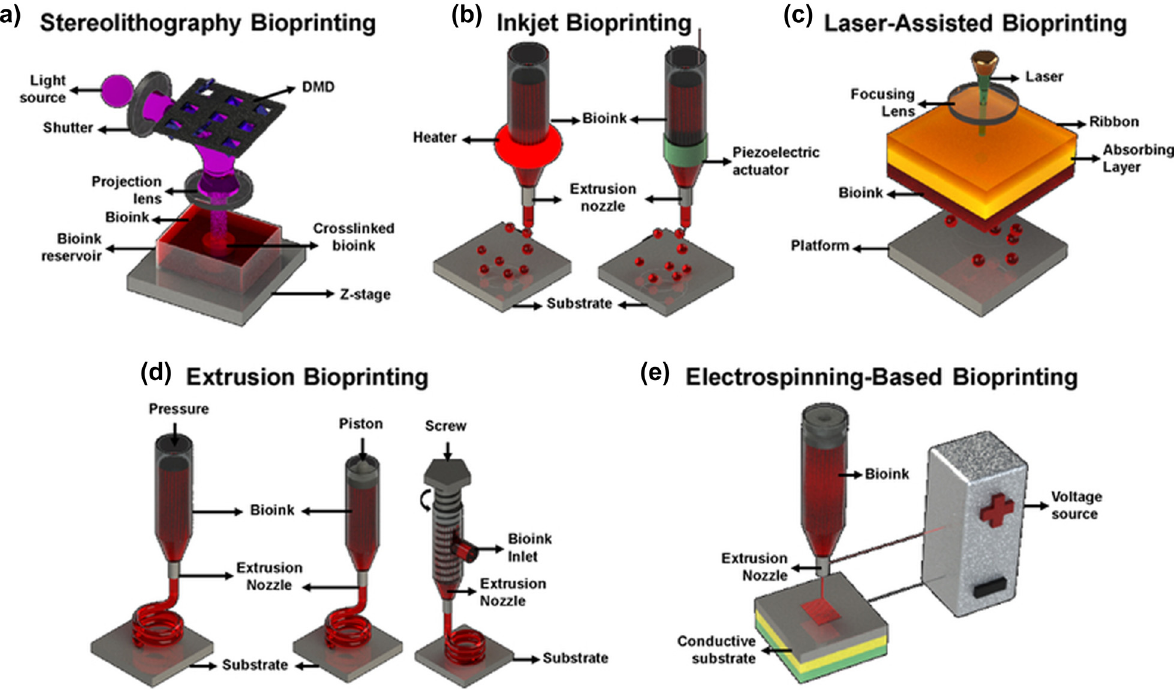
Figure 6: Schematic diagram of di ff erent 3D bioprinting technologies: ( a ) SLA - based bioprinting. ( b ) Inkjet bioprinting with thermal or piezoelectric actuation. ( c ) Laser - assisted bioprinting. ( d ) Extrusion - based bioprinting. ( e ) Electrospinning - based bioprinting. Reproduced with permission from Heinrich et al. [ 96 ]